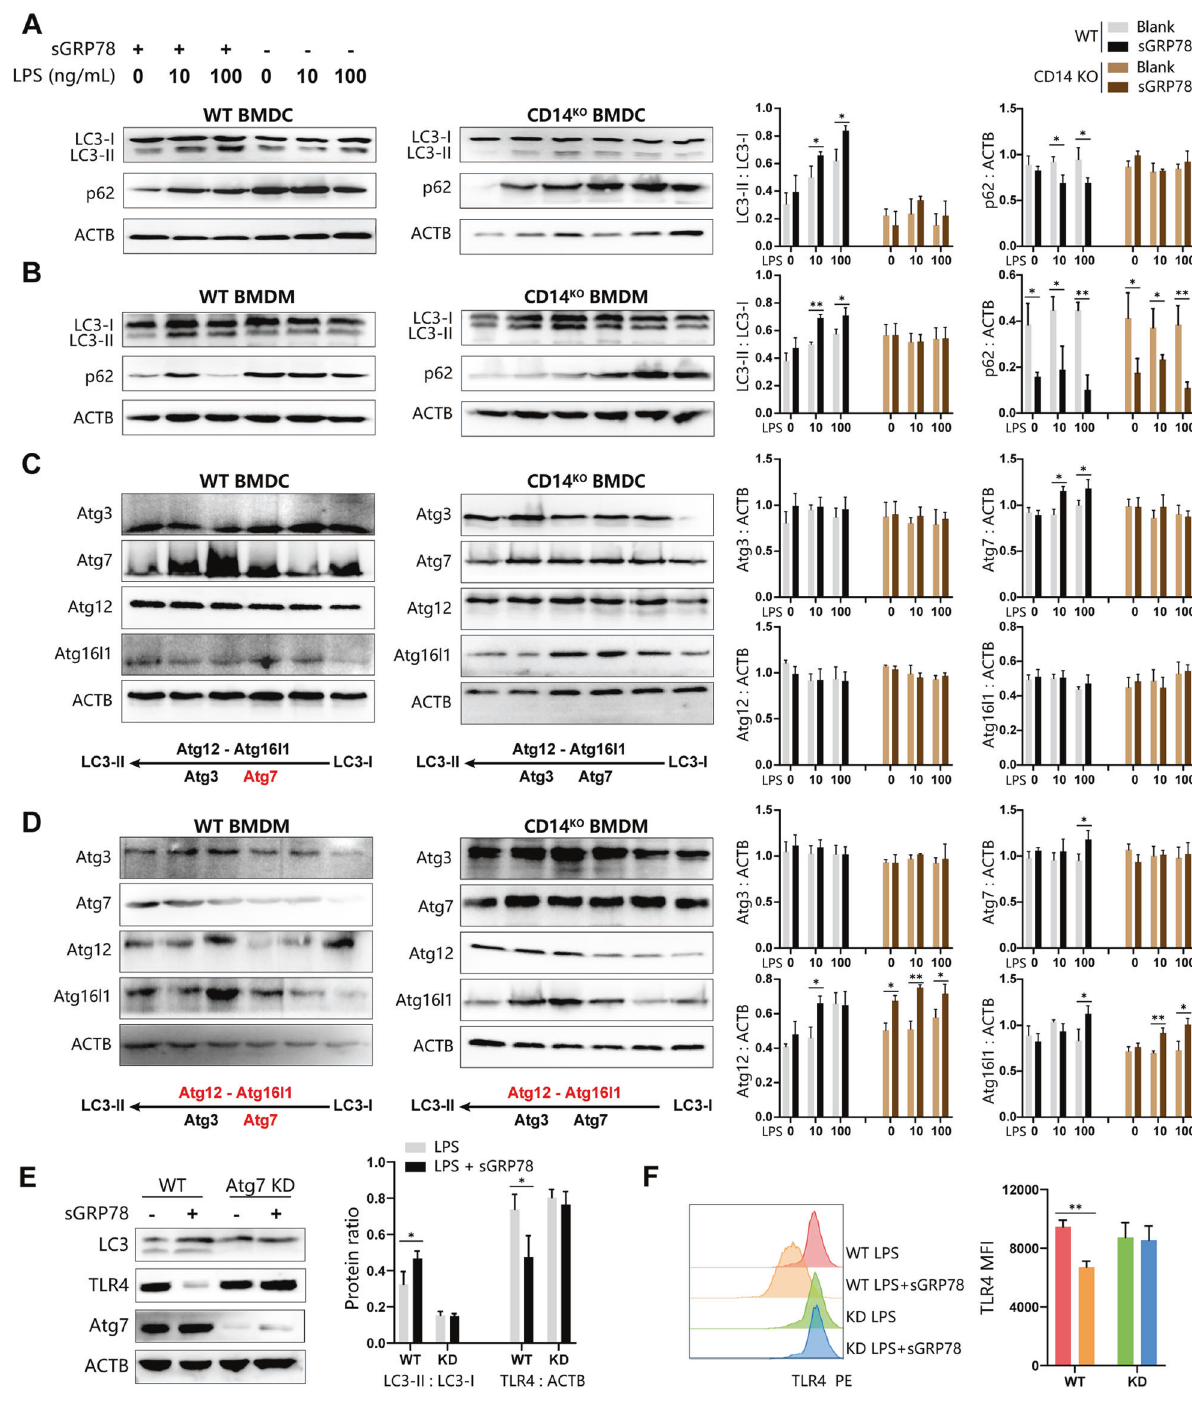
Fig. 3 sGRP78 promotes Atg7-dependent autophagy. Cells were treated with sGRP78 (20 μ g/ml) and/or LPS (0, 10, 100 ng/ml) for 12 h. Whole-cell lysates from BMDCs ( A , C ) or BMDMs ( B , D ) were subjected for immunoblot analysis of LC3, p62 ( A , B ) and Atg3, Atg7, Atg12, Atg16l1 ( C , D ). The upregulated autophagy proteins in GRP78-conditioned cells were highlighted in red in schematic diagram. E , F LC3, TLR4 and Atg7 expression in Wildtypeand Atg7-knockdown BMDCs. * P < 0.05, ** P < 0.01.